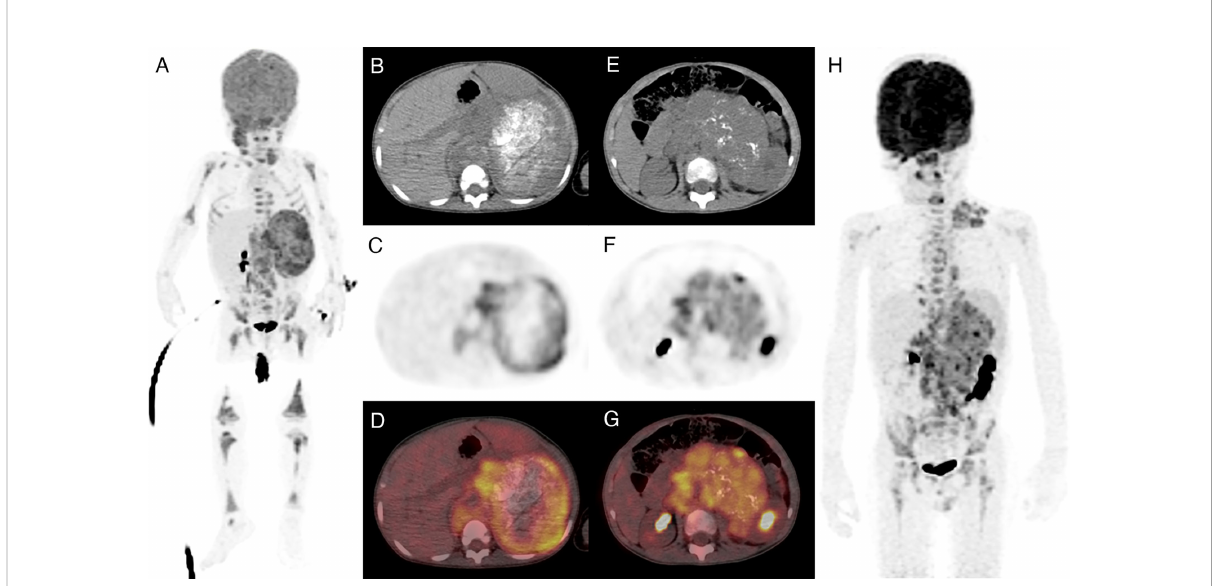
FIGURE 6 Two patients with a high-risk neuroblastoma and high or low intratumor heterogeneity. Both patients had ampli fi ed MYCN and stage 4 diseases. (A – D) A 20-month-old girl with a highly heterogeneous FDG uptake in the primary tumor (high rad-risk). She progressed 21 months after diagnosis. (E – H) A 5-year-old boy with a relatively homogeneous FDG uptake (low rad-risk). The patient remained recurrence free within 5 years of